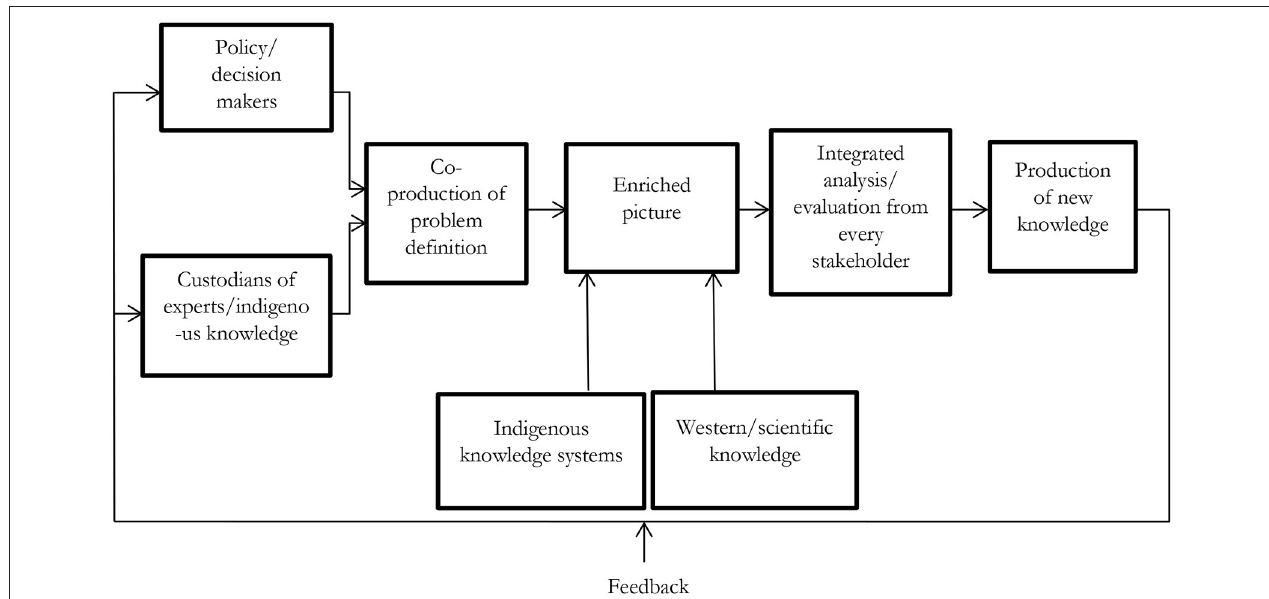
FIGURE 3 | Multiple evidence base approach. Source: Tengö et al.